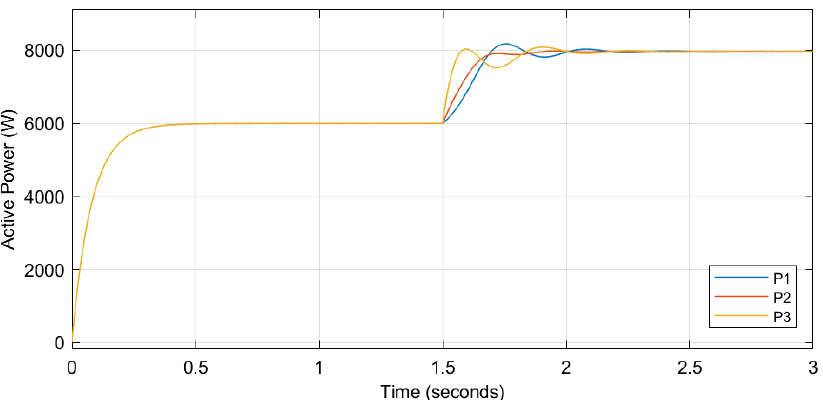
Figure 11. Active power output of the droop controller with typical virtual impedance.